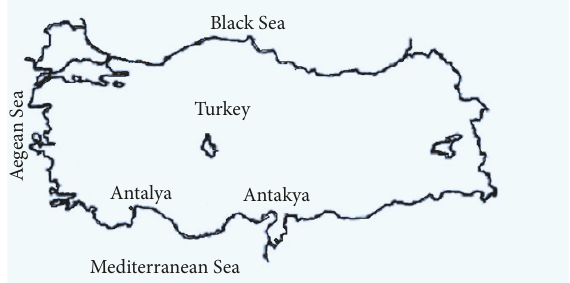
Figure 1: The location of the Antalya and Antakya